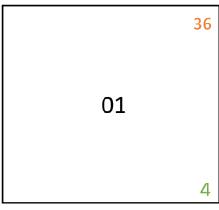
Figure 9. Example of a single industrial